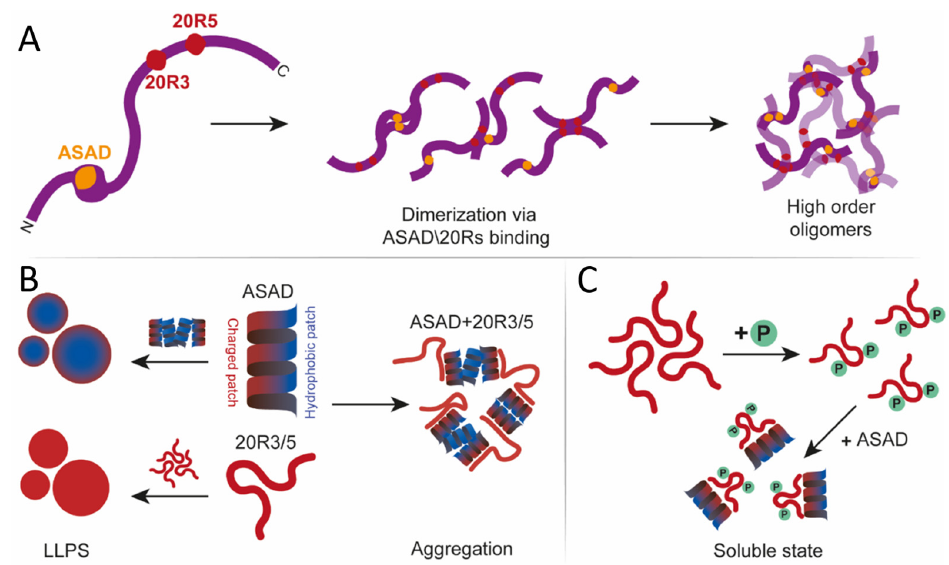
Figure 7. A scheme that describes oligomerization states of APC. ( A ) APC (purple) can dimerize and form higher-order structures via ASAD-ASAD (orange), 20R3-20R3, 20R5-20R5 interactions (red), and ASAD 20R3/5 interactions. ( B ) ASAD hydrophobic patches (blue) assemble droplets by hydrophobic interactions, while the charged patch (red) remains exposed to the polar solvent. 20R3/5 can form droplets by electrostatic interactions. While bound to each other, ASAD and 20Rs do not form droplets. ( C ) Phosphorylation of 20R3/5 prevent droplet formation.